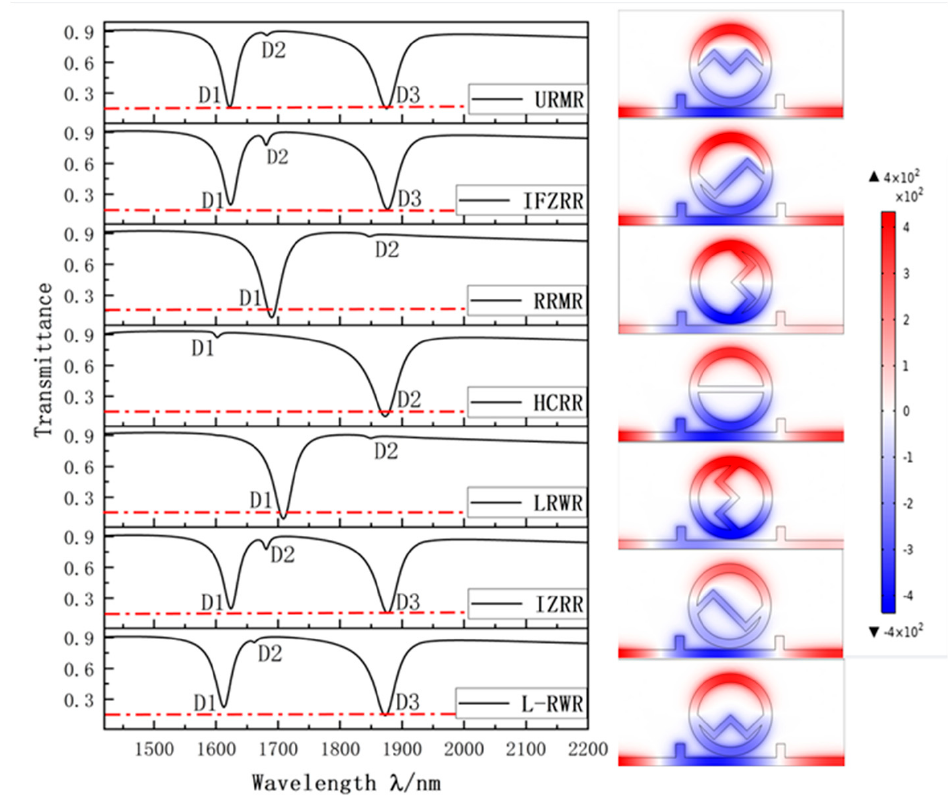
Figure 3. Transmission curves of several structures with upper and lower symmetry, left and right symmetry, and center symmetry with the distribution of the trough magnetic field on the far right. The right graph shows the normalized magnetic field intensity distribution for different structures.